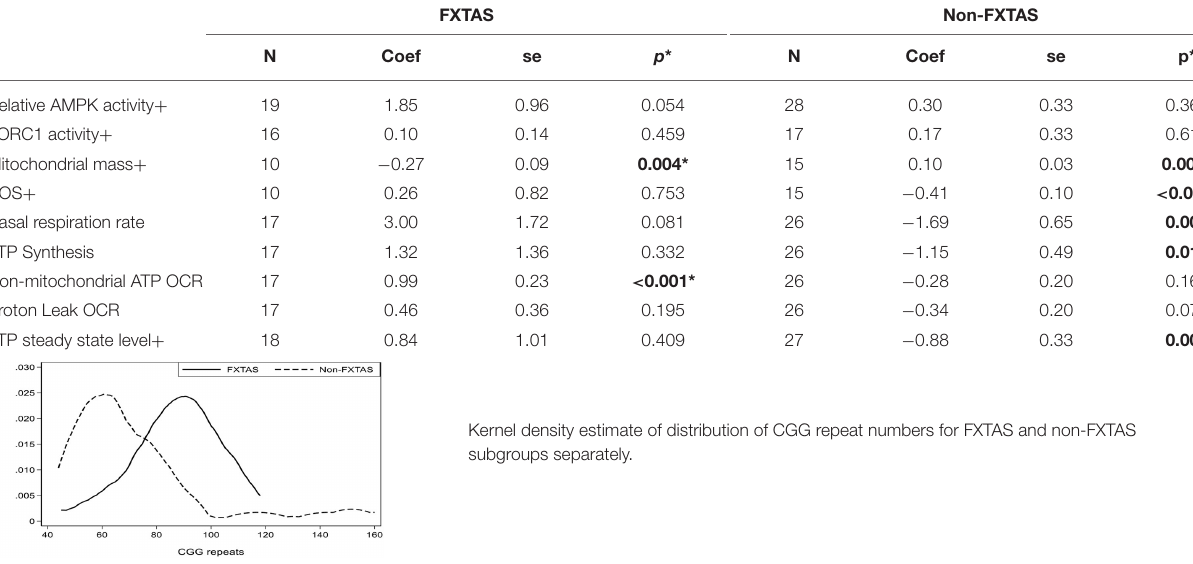
TABLE 1 | Relationship between biochemical variables (outcome) and CGG repeats, separately for FXTAS and Non-FXTAS assessed by robust